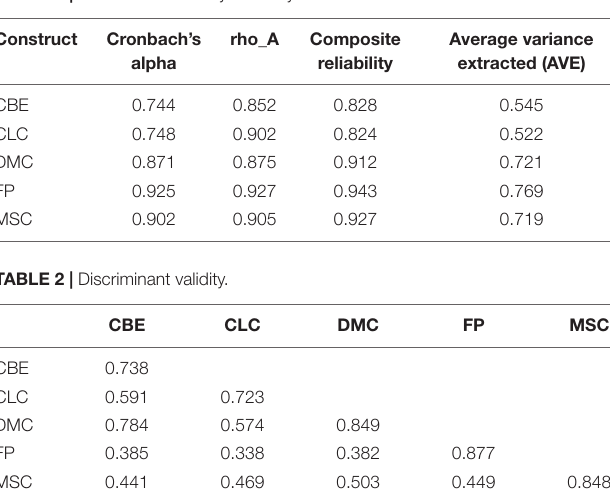
TABLE 1 | Internal consistency reliability.